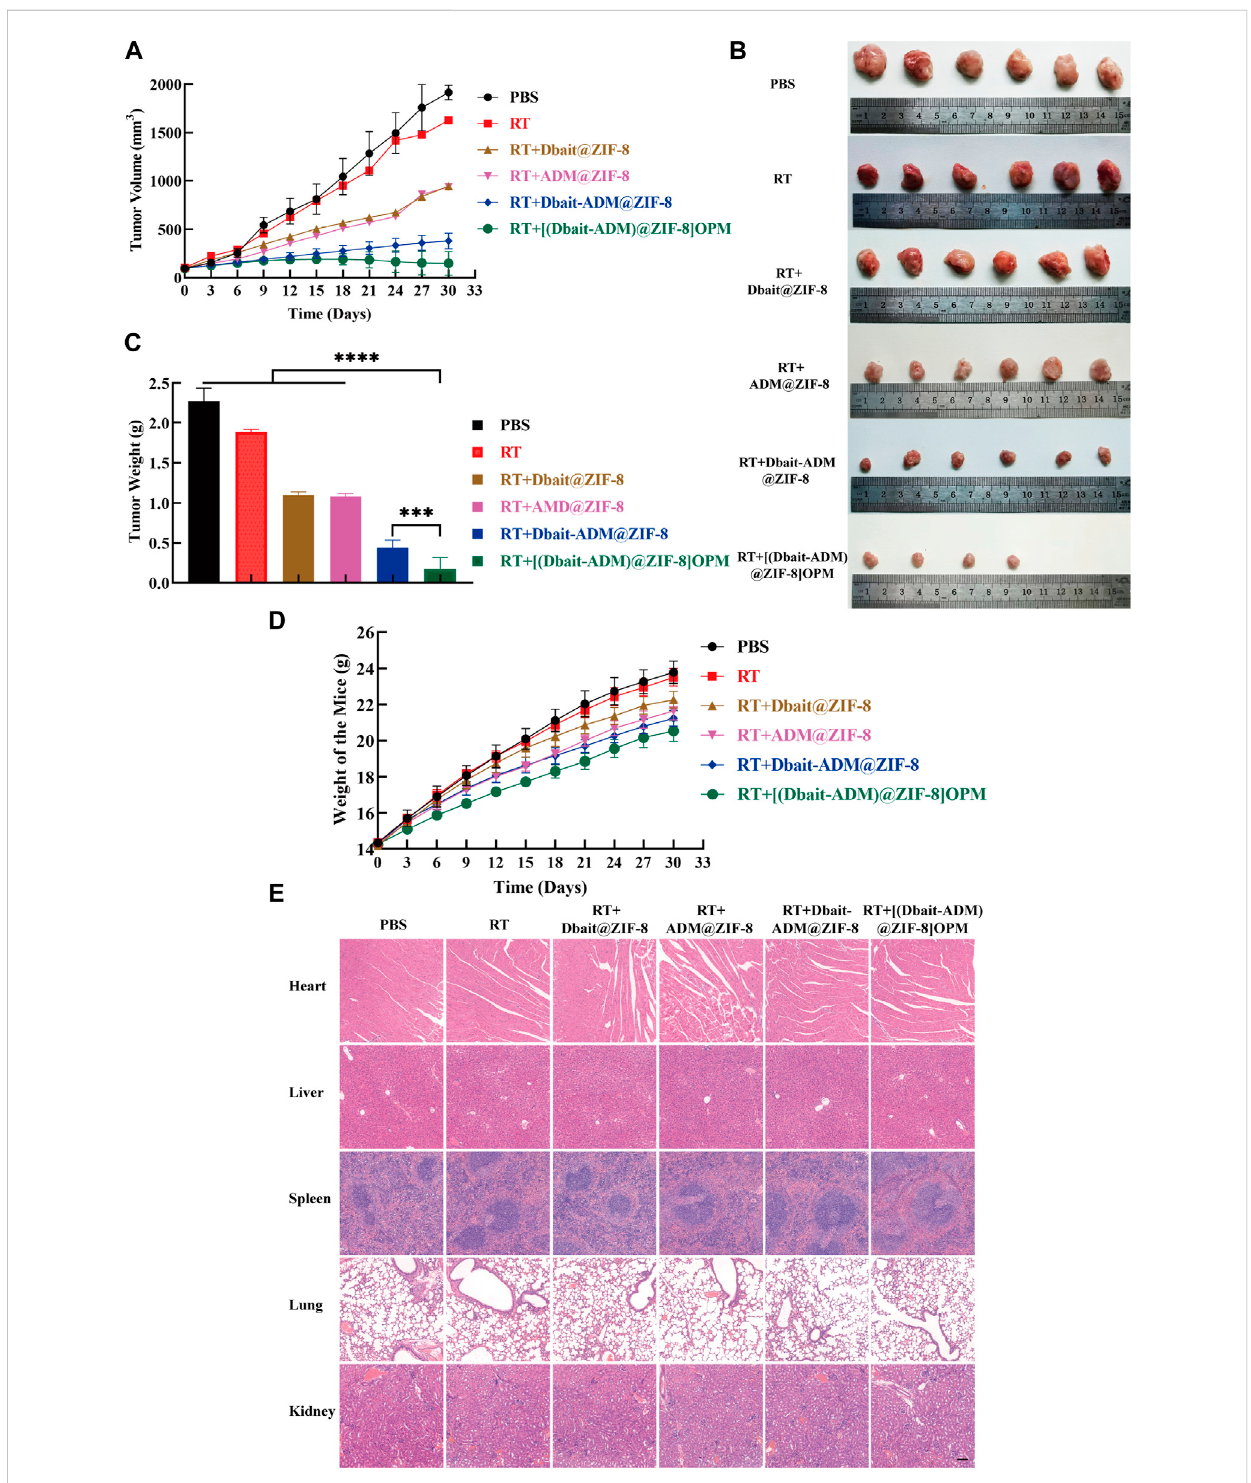
FIGURE 7 Antitumor activity invivo . (A) The tumorgrowth curve. (B) Imagesof excised tumorsofeach groupattheendpoint. (C) Weightoftheexcisedtumors attheendpoint. (D) Theweightchangeofthemiceduringthetreatment.Thebodyweightofthemicewasmonitored(n=6). (E) H&Ehistologicalstaining of nude mice organs after the above treatment. Scale bar, 50 μ m.